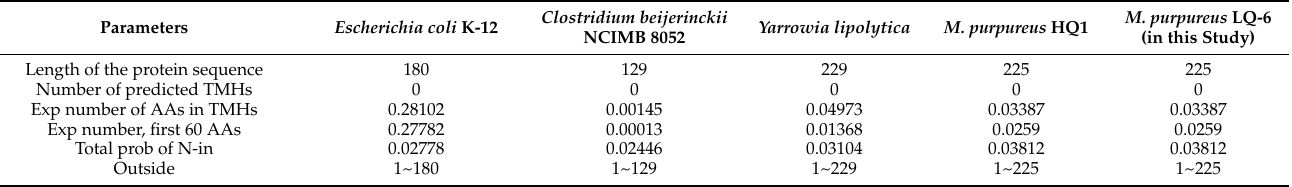
Table 1. Comparison of the TMHMM results of gene nuo I in different